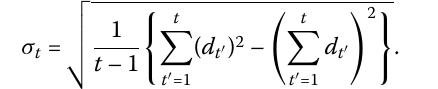
is satisfied. Here, σ t is a seasonal cumulative standard deviation given